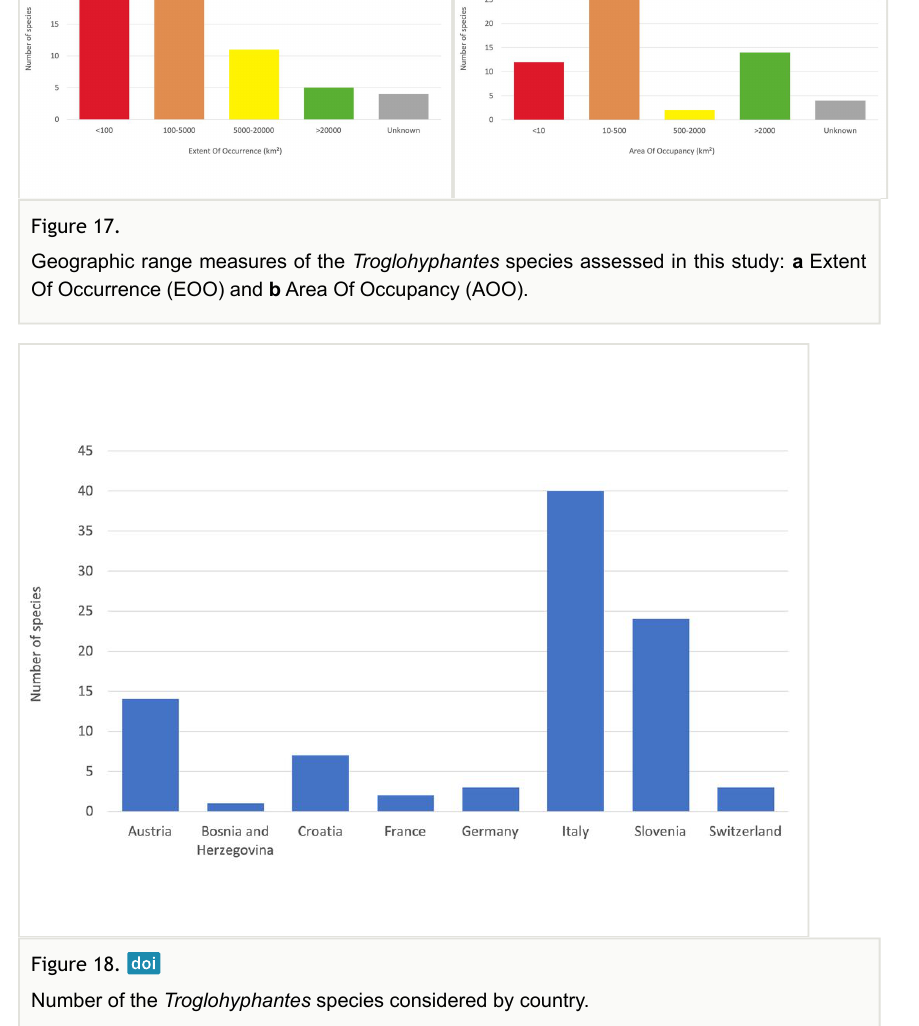
Number of the Troglohyphantes species considered by Trends in EOO, AOO and habitat quality were considered to be stable for 30 species (Fig. 19). These show minor adaptation to subterranean life, being mainly found in the vicinity of the cave entrance or in shallow subterranean habitats and for which no current major threats are known. It seems likely that these species are more able to withstand ecological variations and higher temperature increases compared to highly adapted subterranean species (Mammola et al. 2019a).